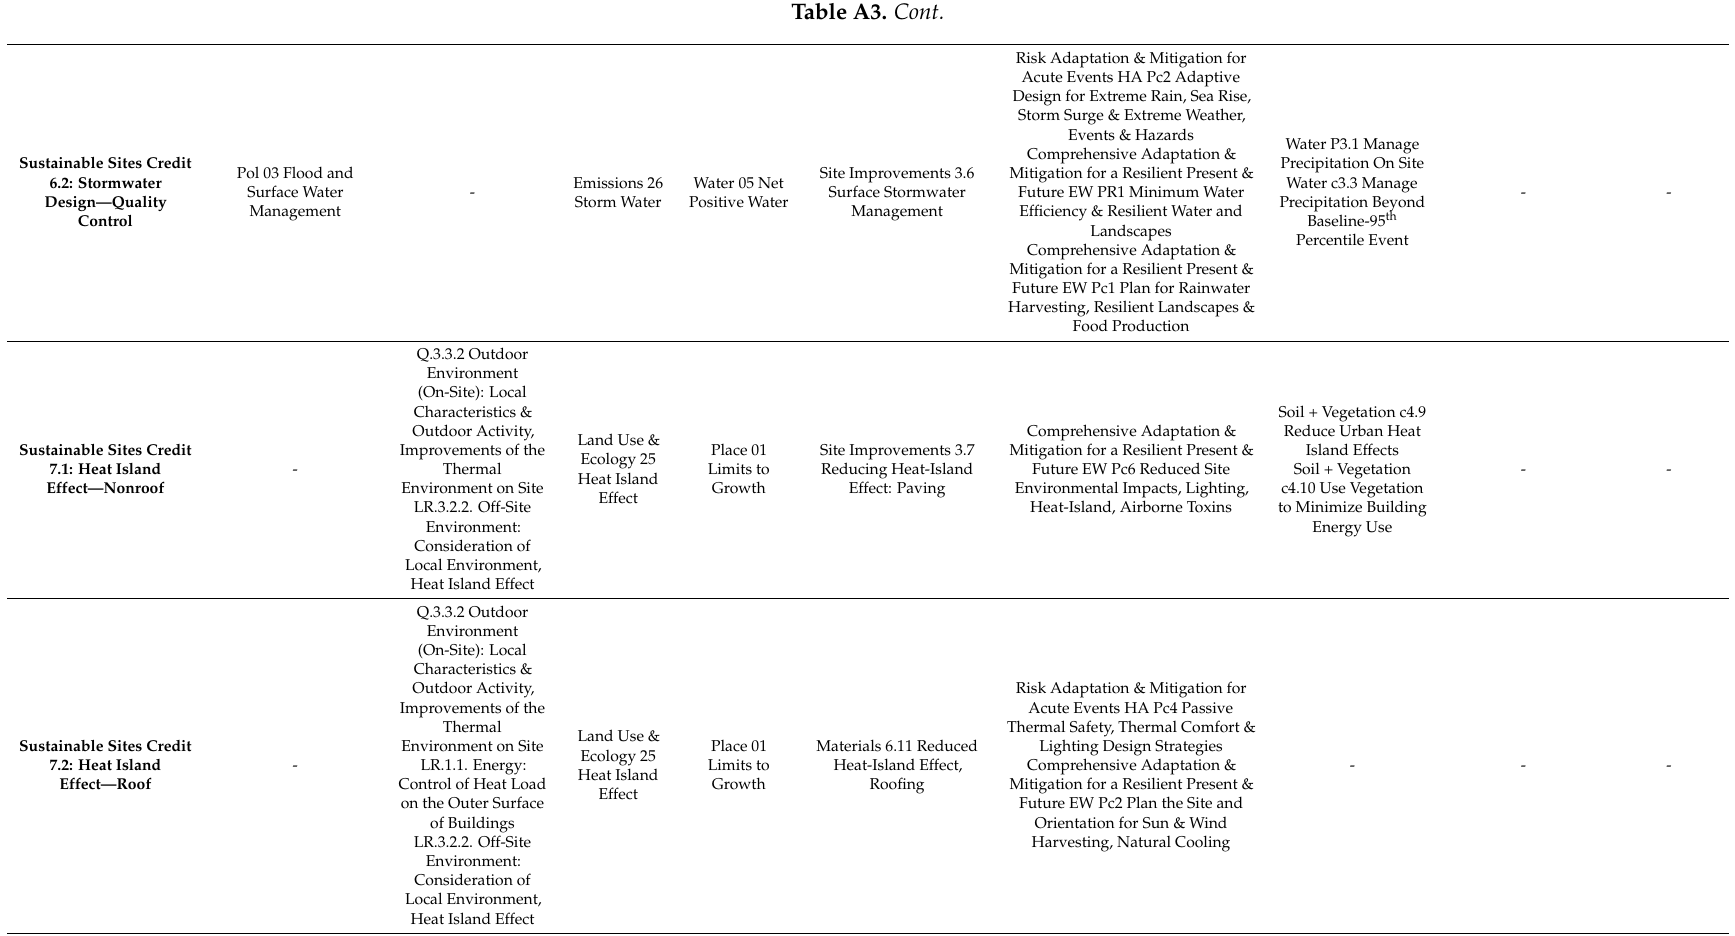
Sustainable Sites Credit 6.2: Stormwater Design—Quality